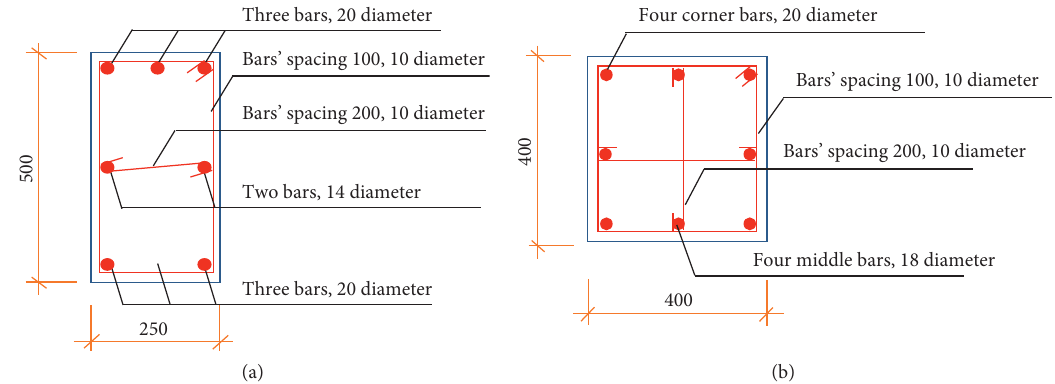
Figure 3: Reinforcement of the beam-column. (a) Reinforcement of the beam. (b) Reinforcement of the column.